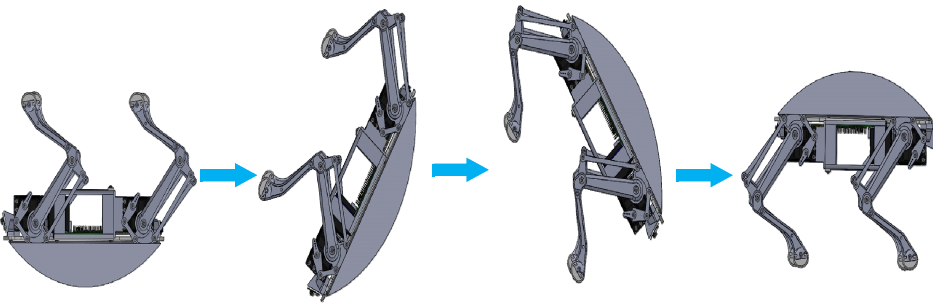
Figure 2. Schematic diagram of the self ‐ recovery method of a quadruped robot from